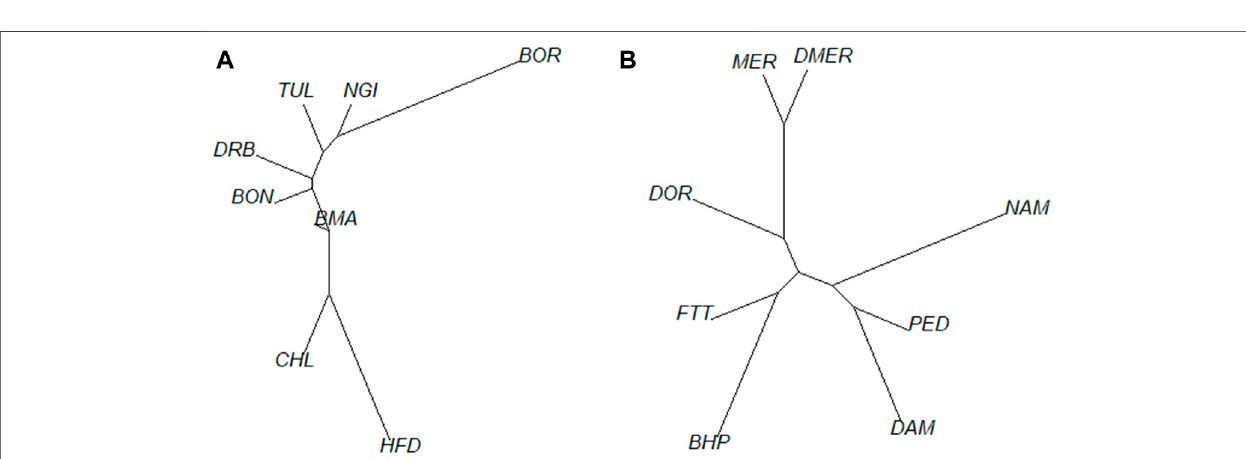
FIGURE 5 | Genetic distance between populations based on pairwise F ST estimates for cattle (A) and sheep (B) .